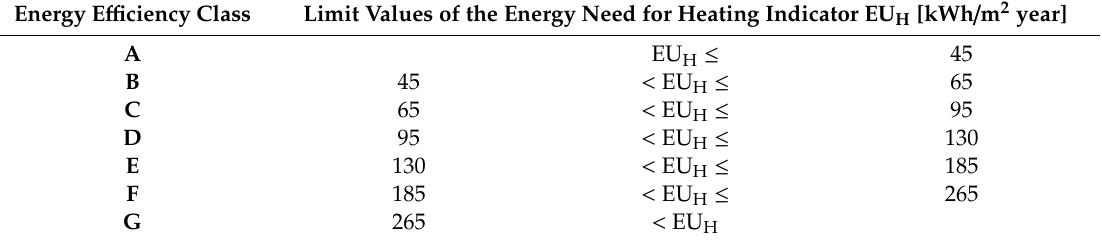
Table 6. EU H limit values for energy